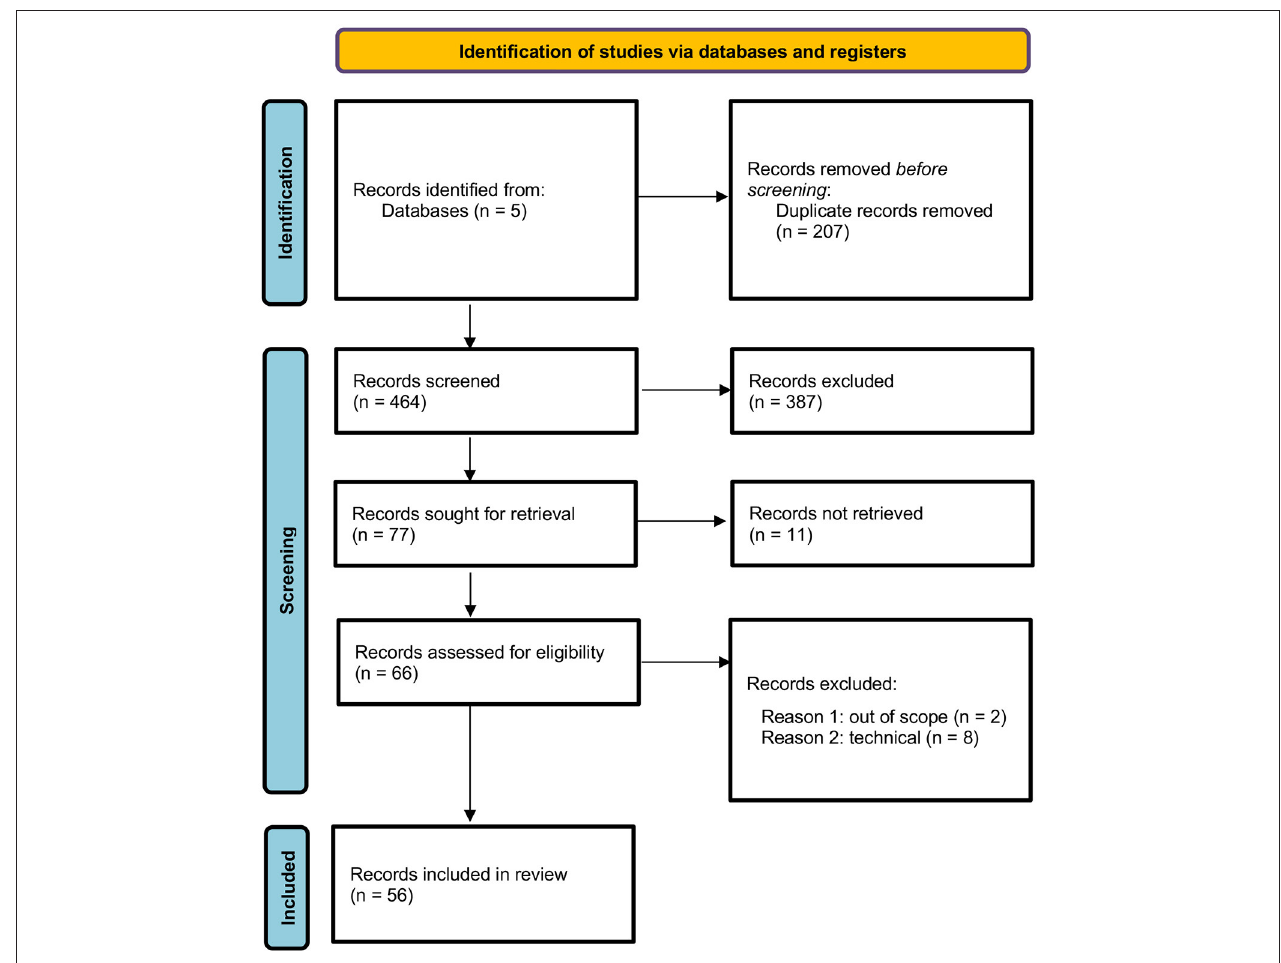
FIGURE 1 | PRISMA flow diagram showing the results of the systematic literature review.